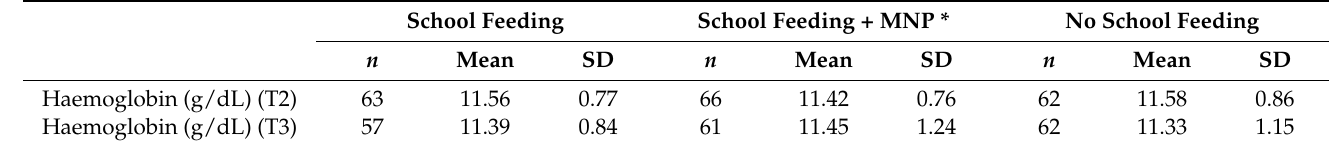
Table 5. Means and standard deviations for haemoglobin at time points T2 and T3 in the intervention and control groups. School Feeding School Feeding + MNP * No School Feeding